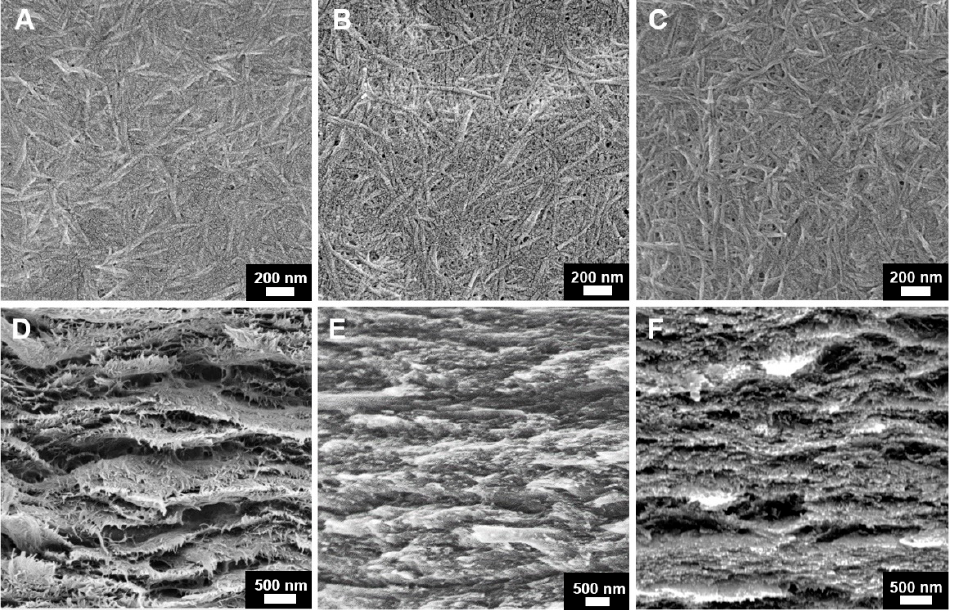
Figure 2. SEM images of ( A – C ) top surface and ( D – F ) cross section of PEDOT:PSS/CNF porous composite paper. ( A , D ) Pristine, ( B , E ) post-treatment with DMSO, and ( C , F ) post-treatment with EG.